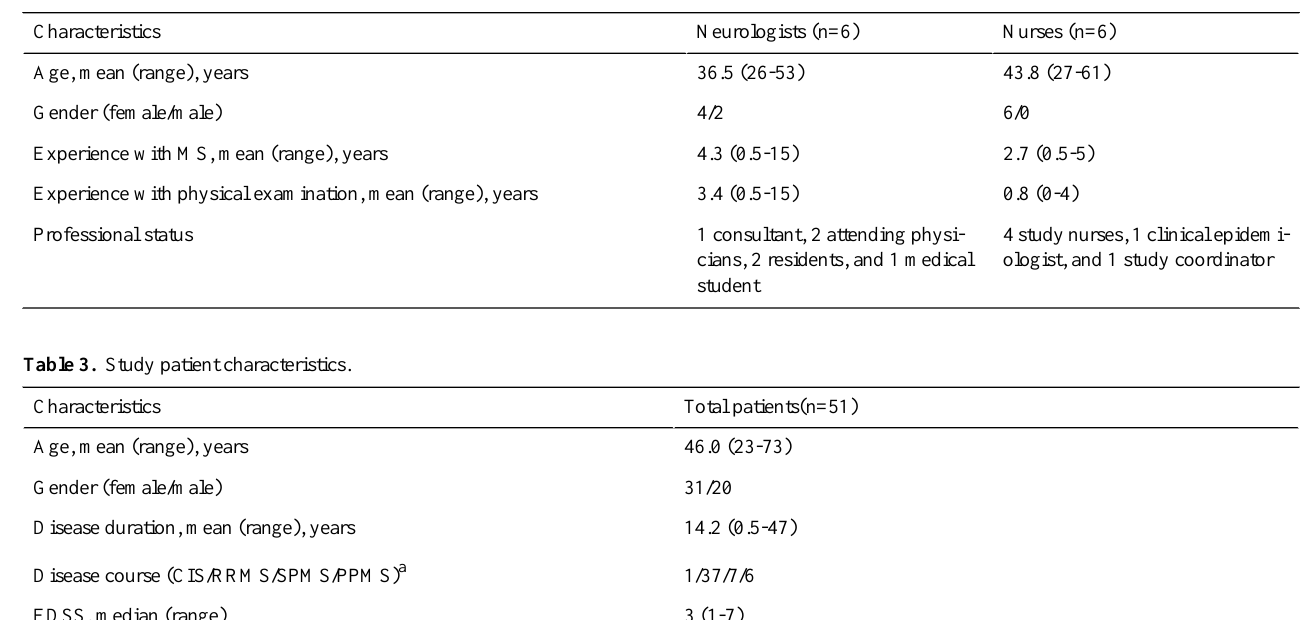
Table 2. Health professional characteristics.